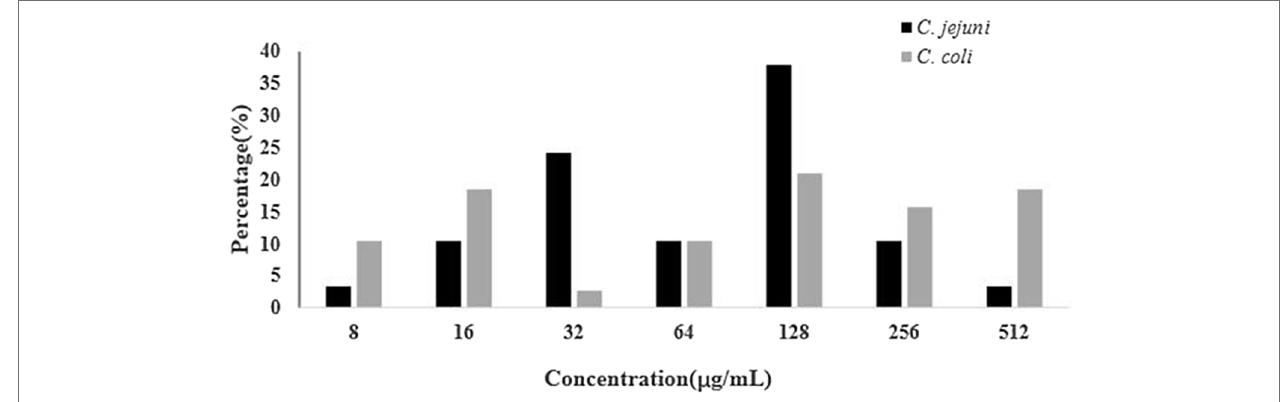
FIGURE 1 | Distributions of gentamicin MICs of gentamicin-resistant Campylobacter